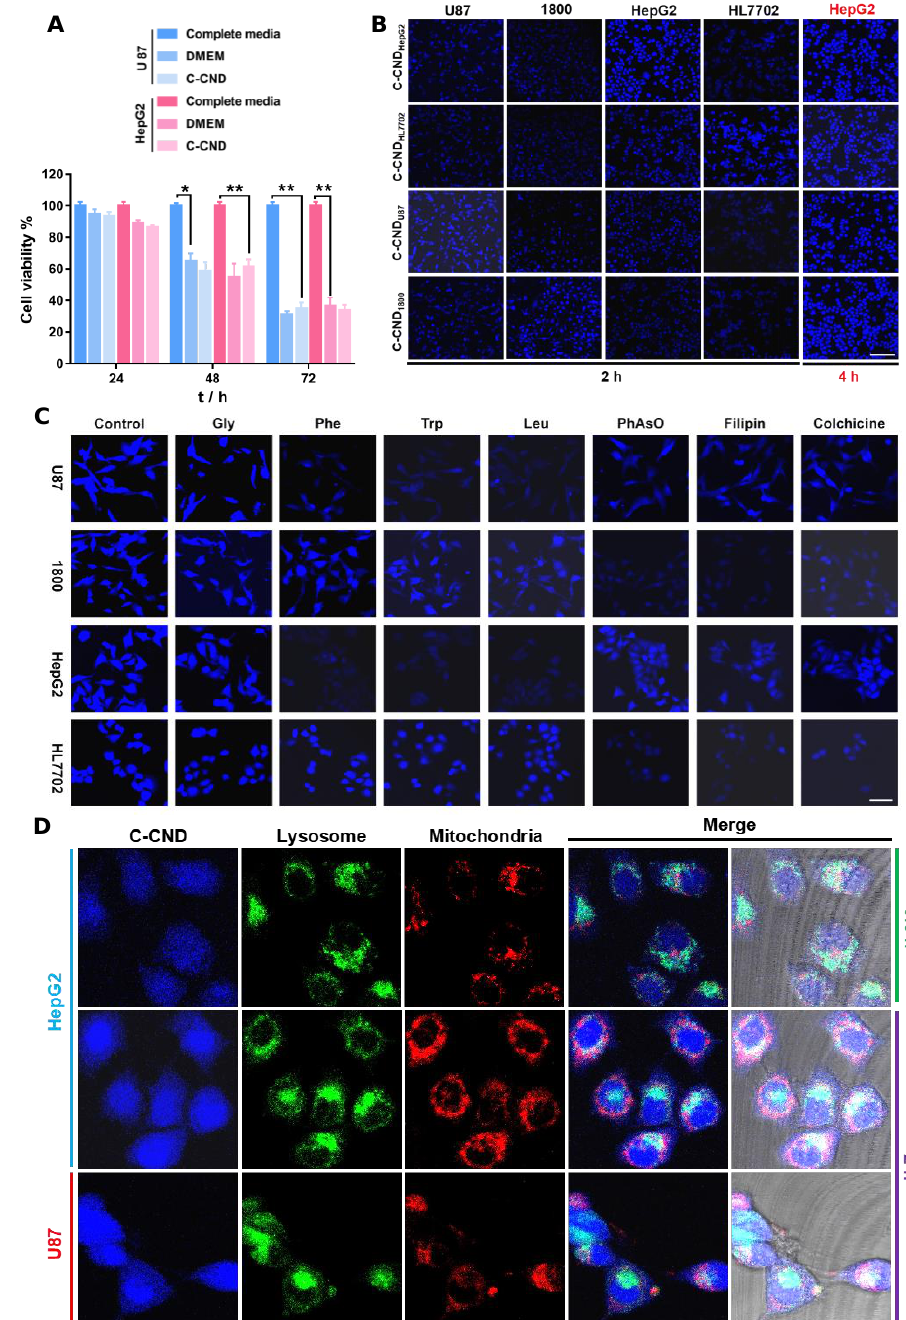
Figure 3. ( A ) Cell viability of U87 cells and HepG2 cells incubated with complete media, DMEM (FBS and glucose free media) and 4 mg/mL of C-CND dispersed in DMEM (U87 cells incubated with C-CND U87 , HepG2 cells incubated with C-CND HepG2 ) for varied time periods. Data are represented as mean ± SD (n = 4). Confocal fluorescence images of tumorous (HepG2 and U87) and normal (1800 and HL 7702 ) cells incubated with different C-CND (80 µ g/mL) for ( B ) varied time periods (Bar = 100 µ m) and ( C ) being pretreated with Gly, Phe, Trp, Leu, PhAsO, filipin, and colchicine, followed by incubation with corresponding C-CND (Bar = 50 µ m). ( D ) The subcellular localization of the C-CND (80 µ g/mL) with different organelles. Green: lysosome. Red: mitochondria. Blue: C-CND. Bar = 10 µ m. Notes: * p < 0.05; ** p <